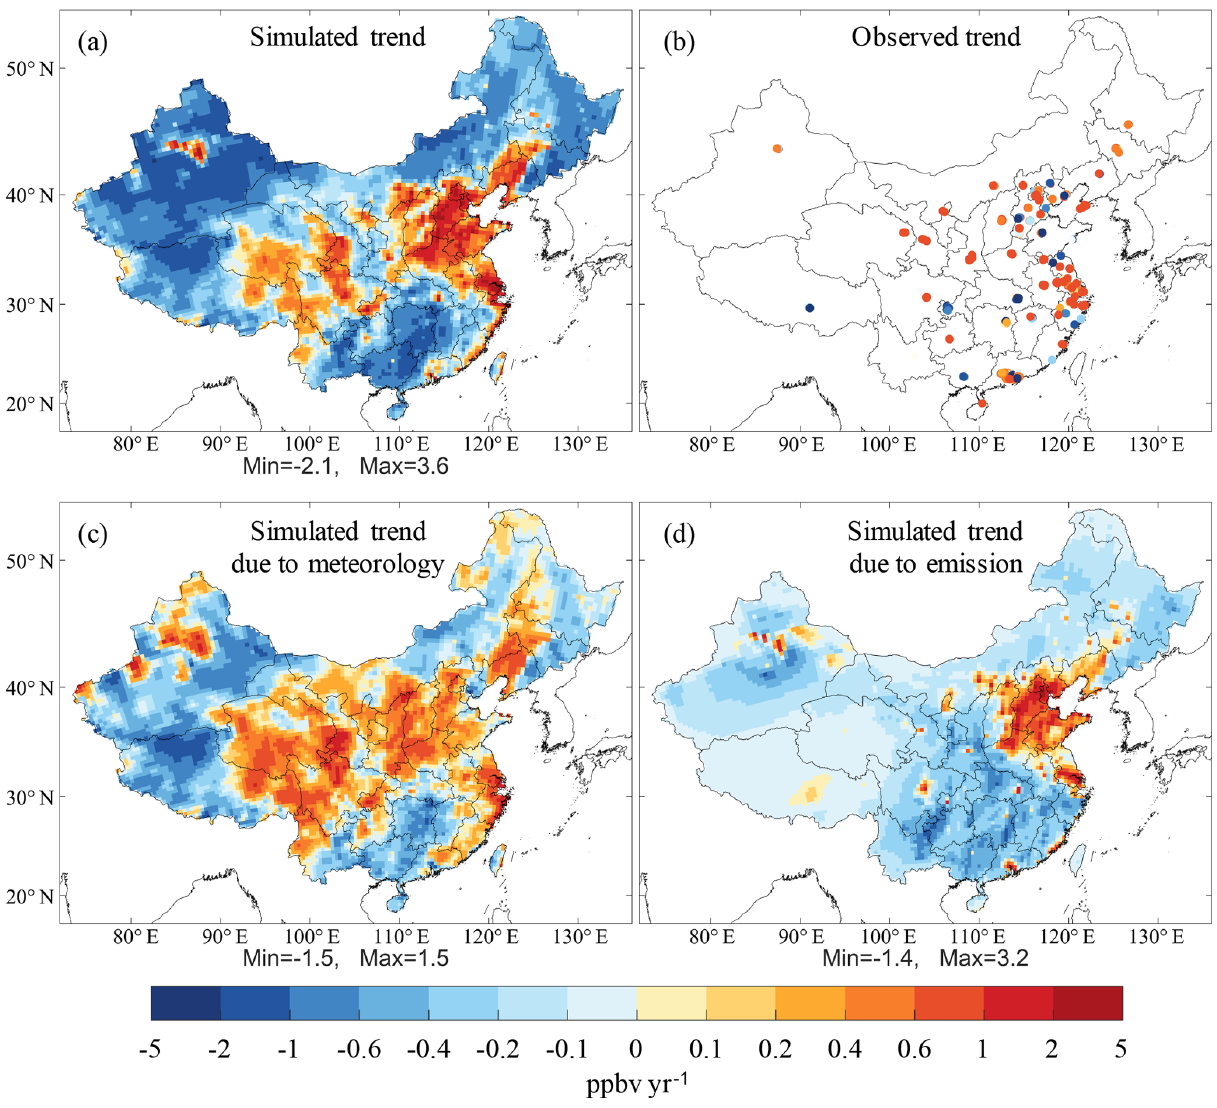
Figure 2. Rates of changes in the simulated (a) and observed (b) surface MDA8 O 3 mixing ratios in summer from 2013 to 2017. In panel (b) , only environmental monitoring sites (493) with data available in all 5 years are presented. (c) and (d) present the rates of changes in the simulated MDA8 O 3 mixing ratios due to variations in meteorological conditions and anthropogenic emissions in summer from 2013 to 2017 (see Methods section). The corresponding p values of regression are presented in Fig.